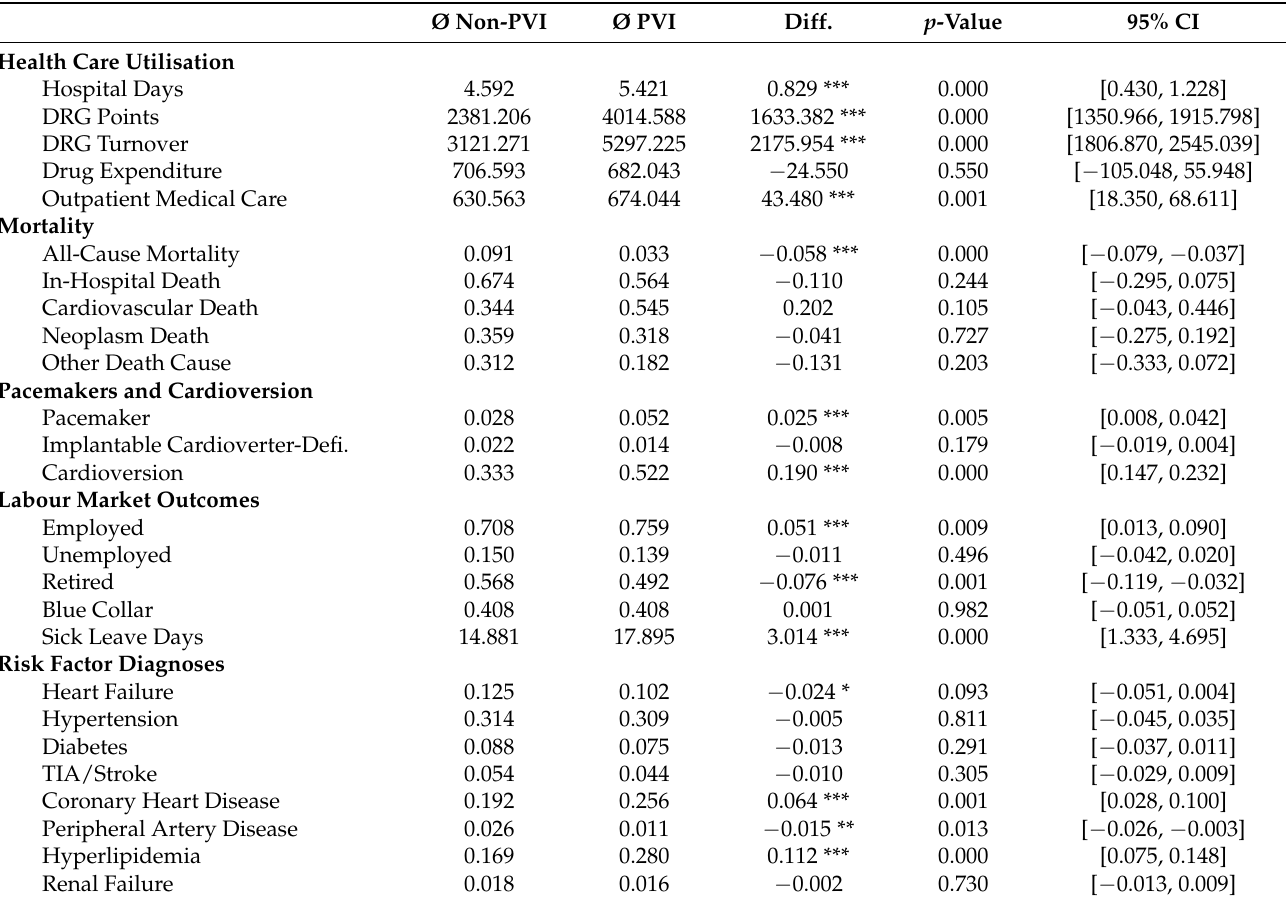
Figure 3. All-cause Mortality. Table 3. Long-term Outcomes ten years after first hospitalization for atrial fibrillation. Ø Non – PVI